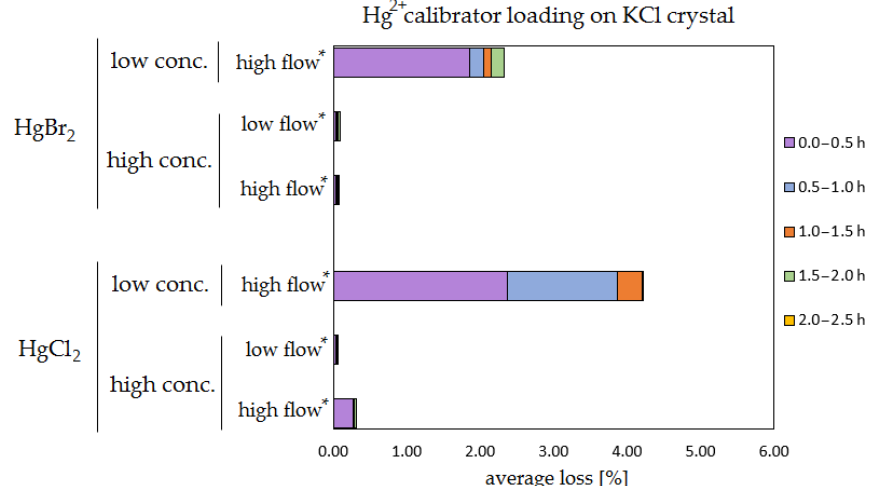
Figure 7. Results of the stability test for the calibrator loading of 197 Hg 2 + (radiotracer) on KCl crystal. Low concentrations were loaded with less than 1ng Hg per time period, and high concentrations were loaded with more than 50ng of Hg per time period. Low airflow experiments were performed with 100mLmin − 1 airflow, while high airflow experiments were performed with 400mLmin − 1 flow. Asterisks mark the results that only have the first four time